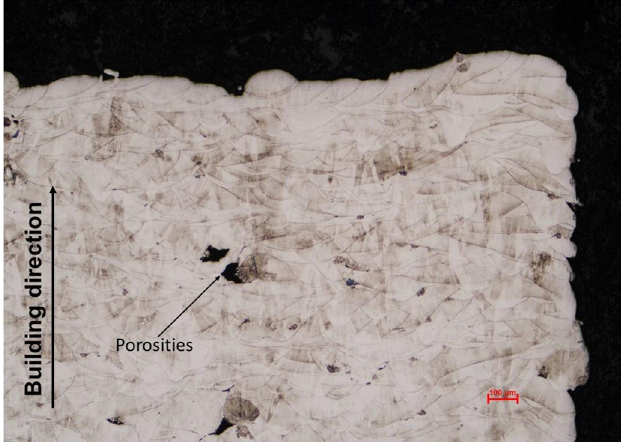
Fig. 5. Microstructure of the specimen manufactured with 150 W laser power and 0.6 m · s (cid:3) 1 scanning speed. Etchant aqua regia.